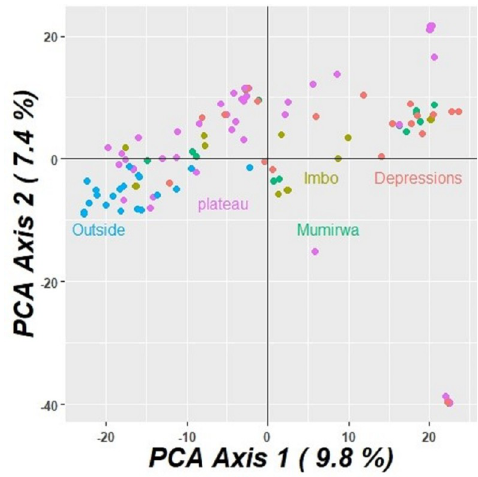
Fig 8. PCoA of cassava populations based on 18,124 SNP’s.